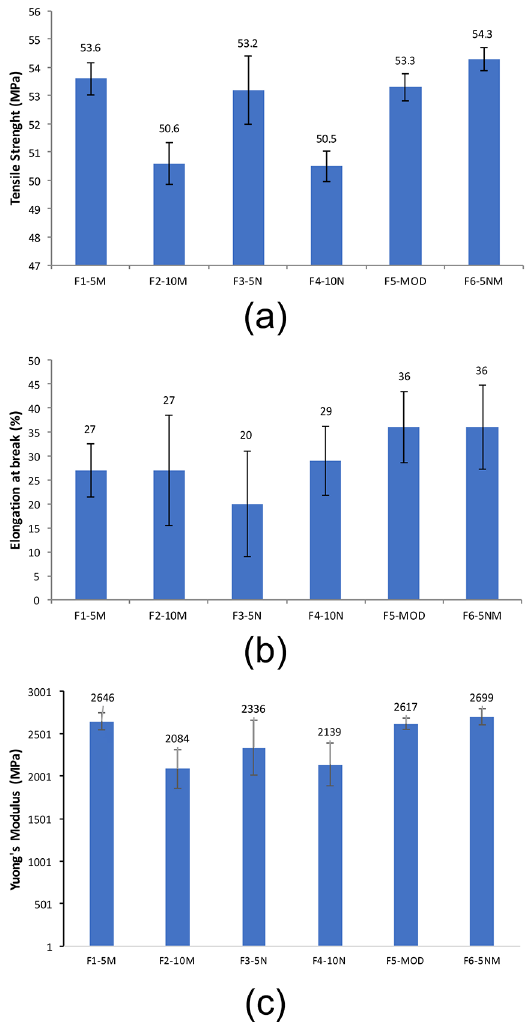
Figure 12. Results of the tensile strength testing of the micro and nano-CaCO PVC compounds: a) Tensile strength, b) elongation 3 at break, c) Young´s